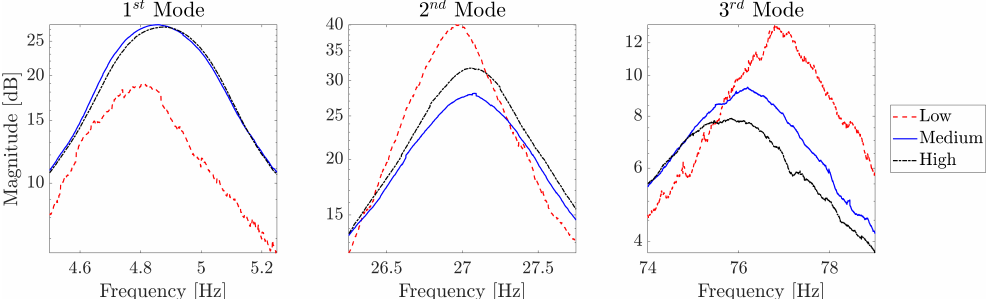
Figure 15. Main spar: comparison of the FRFs of channel #4L for the two input scenarios near resonances.